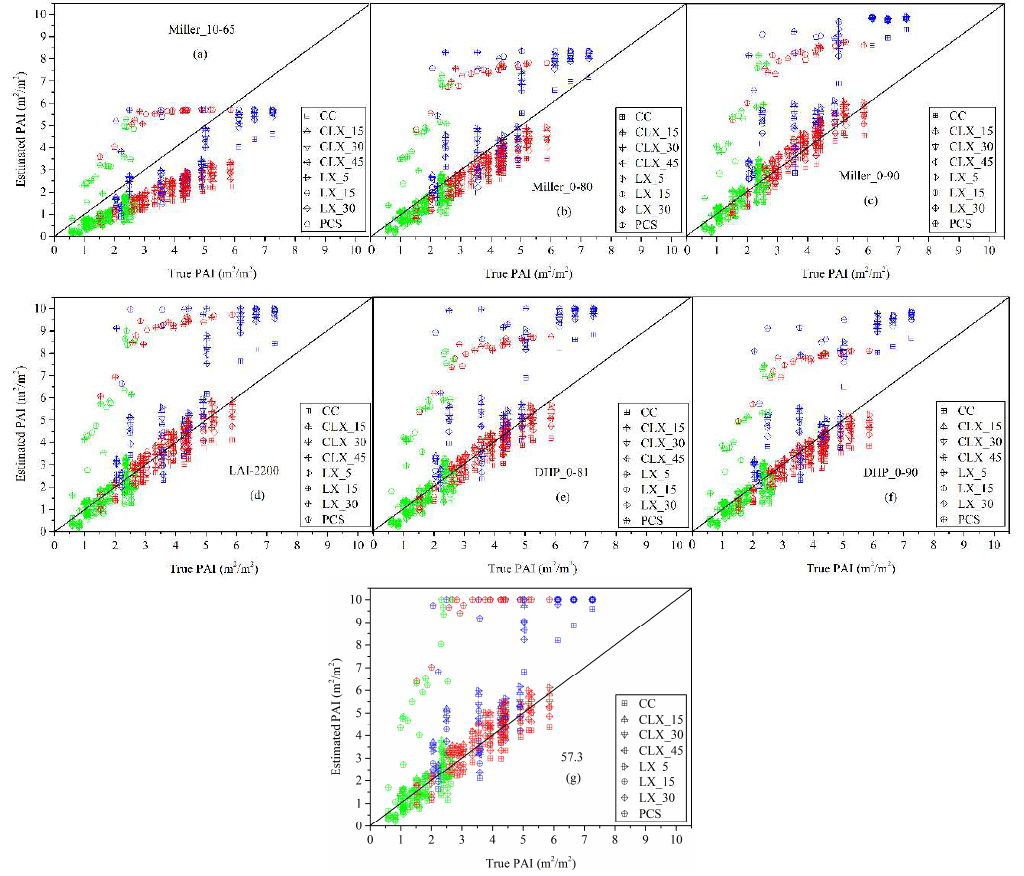
G ,  estimation e e G , estimation e  of leaf-on coniferous scenes. Blue: e  of leaf-on coniferous scenes. Blue: e